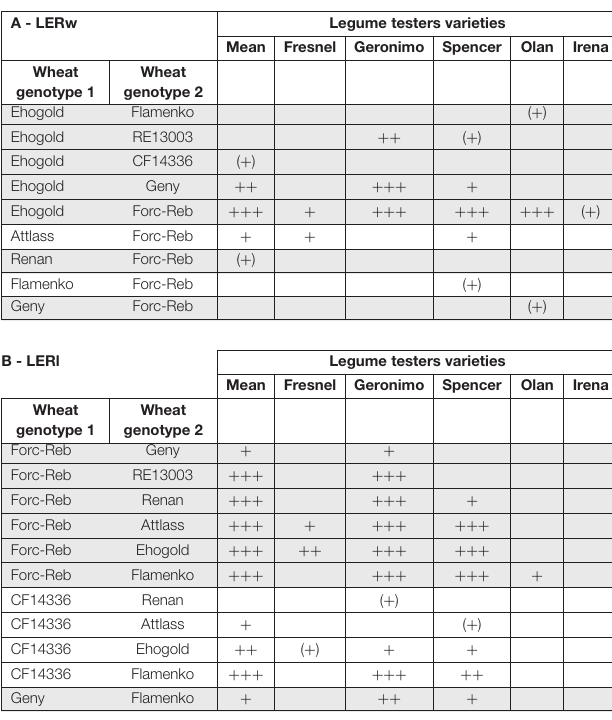
TABLE 8 | Significant differences between pairs of wheat genotypes intercropped with legume tester varieties for their (A) producer and (B) associate effects on average over all testers and for each of the 5 testers